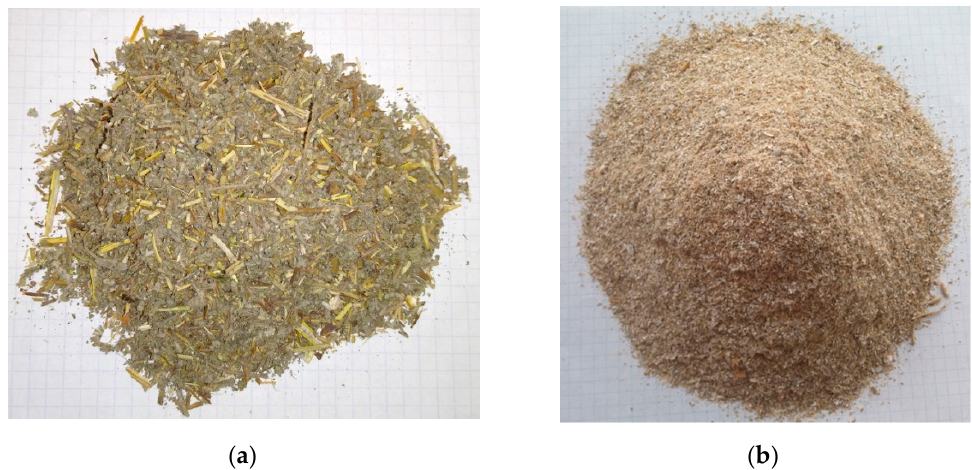
Figure 1. Raw materials for the study: ( a ) sage waste biomass, ( b ) rye bran.